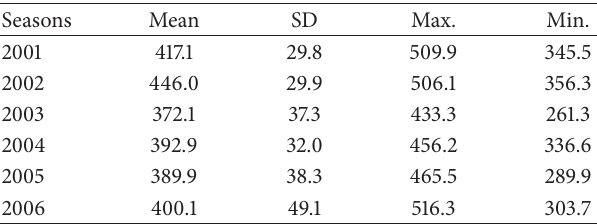
Table 1: The average, standard deviation, maximum and minimum values of ETa in all 80 counties from 2001 to 2006